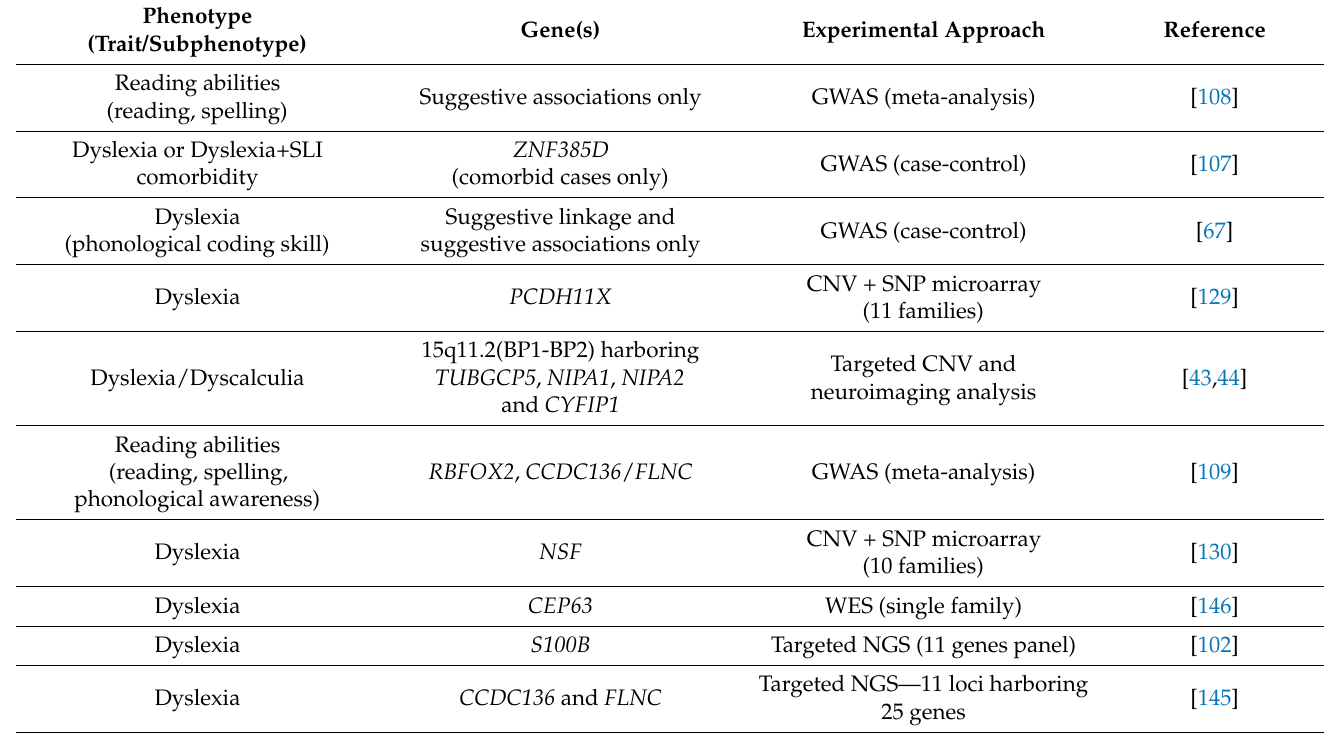
Table 3. Recent studies (2013–2021) reporting novel genomic loci and genes associated with SLD and related traits using high-throughput